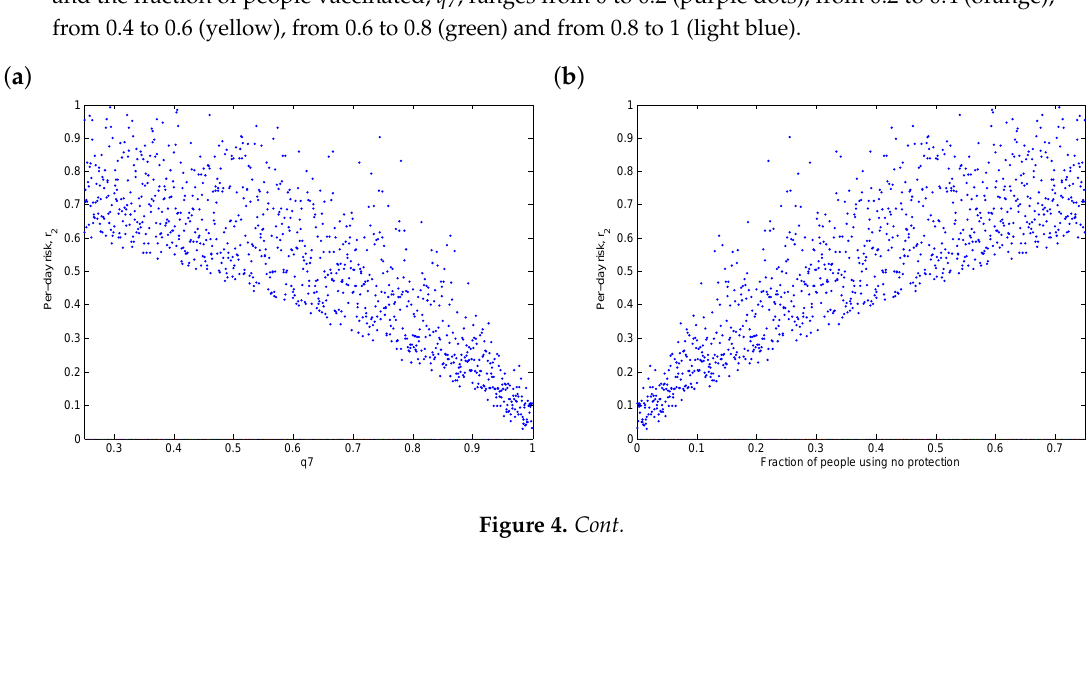
Figure 3. Sensitivity of the daily risk of COVID-19 to transmission rates when the only protection option available is the vaccine. ( a ) The red dots represent the pre-vaccination risk of infection, while the blue dots represent the post-vaccination daily risk. The fraction of people getting vaccinated, q 7 , ranges from 0.25 to 1. ( b ) The outcome variable is the daily risk of infection after vaccination, r 2 , and the fraction of people vaccinated, q 7 , ranges from 0 to 0.2 (purple dots), from 0.2 to 0.4 (orange), from 0.4 to 0.6 (yellow), from 0.6 to 0.8 (green) and from 0.8 to 1 (light blue).